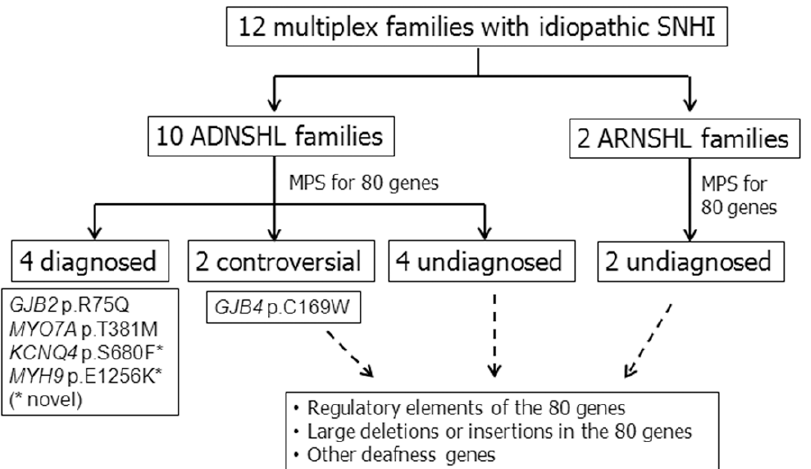
Figure 6. Summary of the genetic diagnostic results obtained in the present study. Twelve multiplex families with idiopathic SNHI, including 10 ADNSHL and 2 ARNSHL families, were subjected to MPS for 80 known human deafness genes. Four out of 10 ADNSHL families were diagnosed to segregate causative variants, including GJB2 p.R75Q, MYO7A p.T381M, KCNQ4 p.S680F, and MYH9 p.E1256K. The GJB4 p.C169W variant of controversial pathogenicity was identified in another two ADNSHL families. In addition to the 2 families with GJB4 p.C169W, we were unable to achieve a genetic diagnosis in the other 4 ADNSHL families and the 2 ARNSHL families. The cause of SNHI in these undiagnosed families might be attributed to genetic defects in the regulatory elements of the 80 genes, large deletions or insertions of . 100 bp in the 80 genes, or even other deafness genes. SNHI, sensorineural hearing impairment; ADNSHL, autosomal dominant nonsyndromic hearing loss; ARNSHL, autosomal recessive nonsyndromic hearing loss; MPS, massively parallel sequencing.